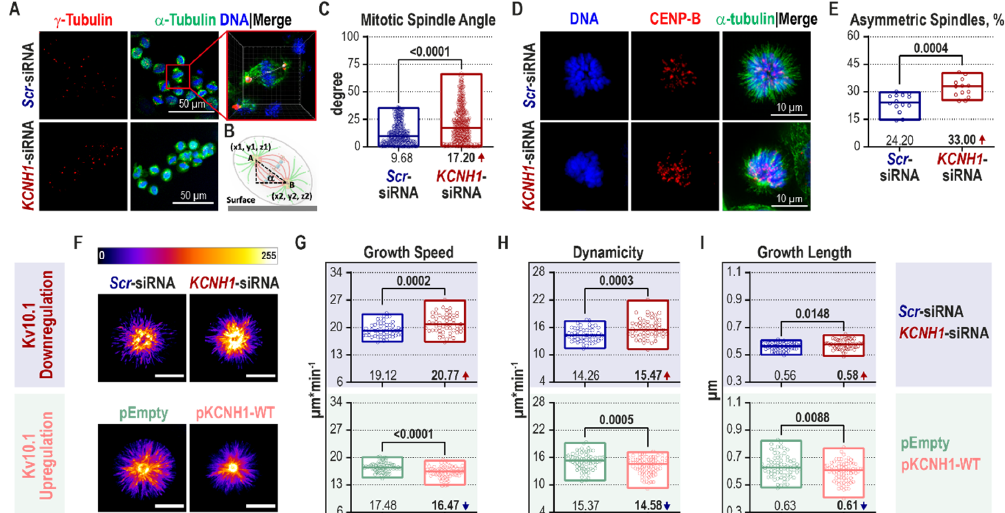
Figure 3. Tilted mitotic spindles and increased microtubule plus-end growth rates are observed in Kv10.1-deficient HeLa cells. ( A – C ) Hela cells were transiently transfected with either Scr- or KCNH1- siRNA and synchronized at the metaphase with consecutive thymidine and nocodazole treatments. ( A ) Maximal intensity projections of z-stacks (0.2 µm step size) of cells in metaphase are represented (scale bar, 50 µm) where the mitotic spindle is in green (α-tubulin), centrosomes—in red (γ-tubulin), and DNA—in blue (Hoechst 33342). The mitotic spindle angle was defined using the Imaris software as shown in the zoomed-in inset and schematically explained in ( B ). ( C ) The results of the mitotic spindle angle measurement are plotted (>50 events per experiment, n = 5 independent synchronization experiments; Mann–Whitney U-test , min to max range with the median indicated as a line are shown). ( D – E ) HeLa cells were transfected with respective siRNAs, grown until 70% confluency, treated with 2.5 µM DME for 4 h. The monopolar spindles were visualized with α-tubulin staining (green), and chromosomes with CENP-B (kinetochores, red) and DNA (Hoechst 33342, blue). ( D ) Example images of monopolar spindles are presented. ( E ) The percentage of asymmetric monopolar spindles is plotted (1500 monopolar spindles per condition per experiment, n = 3 independent synchronization experiments; Mann–Whitney U-test ; min to max range with the median indicated as a line are shown). ( F – I ; Videos S1–S4) HeLa cells were transiently co-transfected with pEB3-tdTomato and the indicated siRNAs (panel in light blue) or plasmid DNAs (panel in light green); 48 h later treated with 2.5 µM DME for 4 h. Microtubule growth was tracked in a series of images taken every 500 ms for 1 min. ( F ) Maximal intensity projections of time-lapse images over the recorded time are shown (“Red Fire” LUT is applied, scale bar, 10 µm). ( G – I ) Parameters calculated by the U-Track software are plotted (>25 cells per condition per experiment, n = 3 independent synchronization experiments; Mann–Whitney U-test , min to max range with the median indicated as a line are shown). (DME—dimethylenastron; LUT—look-up table; pEB3-tdTomato—a plasmid expressing end-binding protein 3 tandem dimer tomato fluorescent protein).